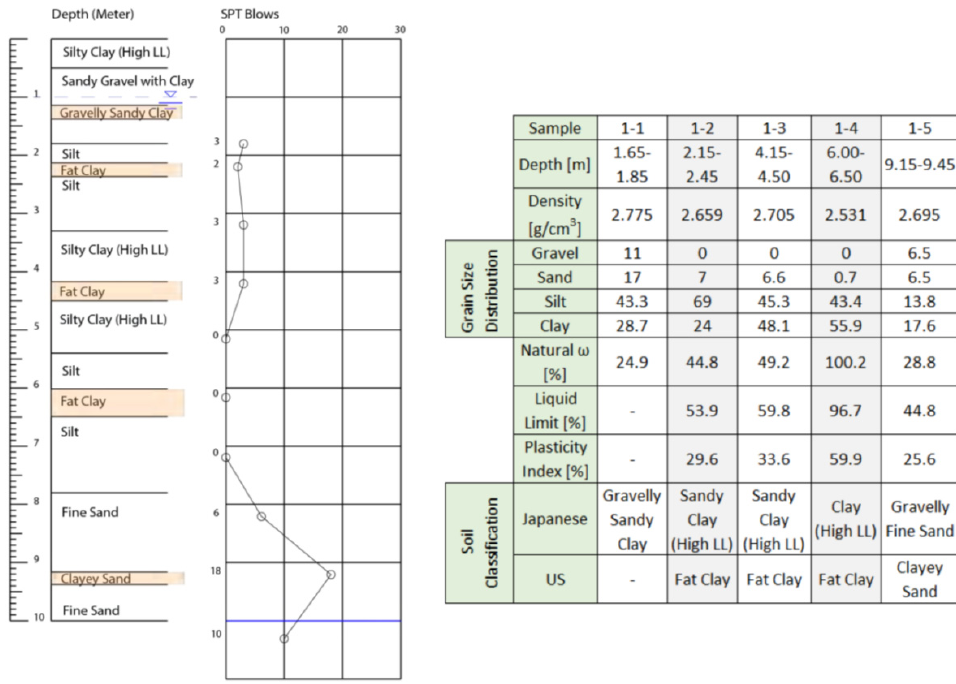
Figure 9. SPT characterization, interpreted soil profile, and laboratory index test results for Site 1 (after Anderson [40]).